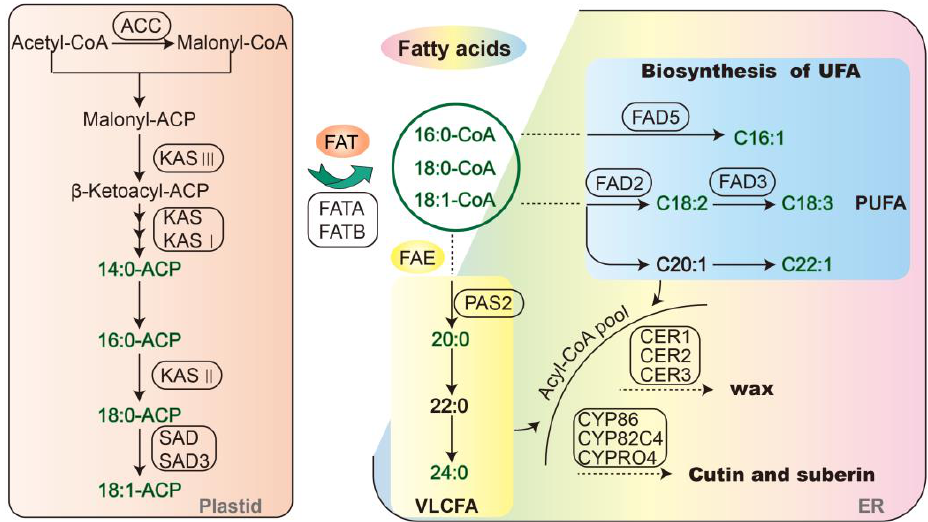
Figure 5. Fatty acid biosynthesis pathway and main related genes. ACC, acetyl-CoA carboxylase; KAS, 3-ketoacyl-ACP synthase; SAD, stearoyl-ACP desaturase; FAD, fatty acid desaturase; FAT, fatty acyl-ACP thioesterase; FAE, fatty acid elongase complex; PAS, very-long-chain (3R)-3-hydroxyacyl-CoA dehydratase PASTICCINO 2; CER, ECERIFERUM; CYP, Cytochrome P450; UFA, unsaturated fatty acids; PUFA, polyunsaturated fatty acids; VLCFA, very long-chain fatty acids; ER, endoplasmic reticulum.